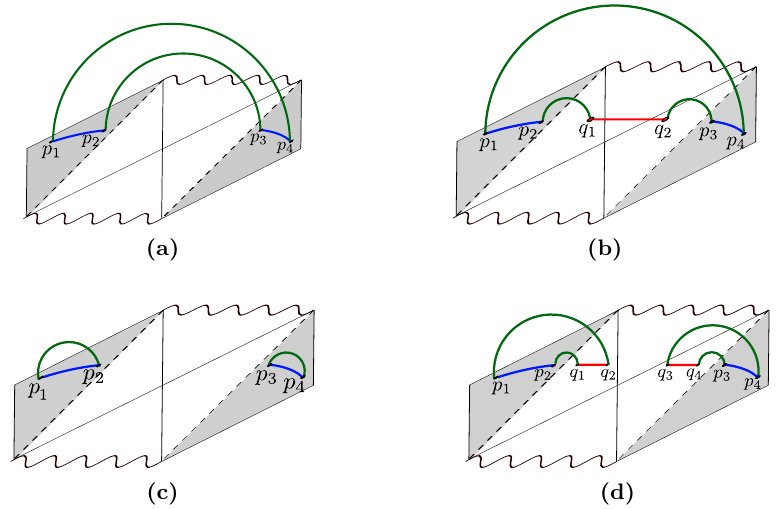
Figure 2. Extremal surfaces that extend into the 3d bulk from the Penrose diagram in figure 1 playing the role of the 2D boundary. (a) → (c) is a thermalization transition, which can be interrupted by the island configuration (b). Surface (d) is always